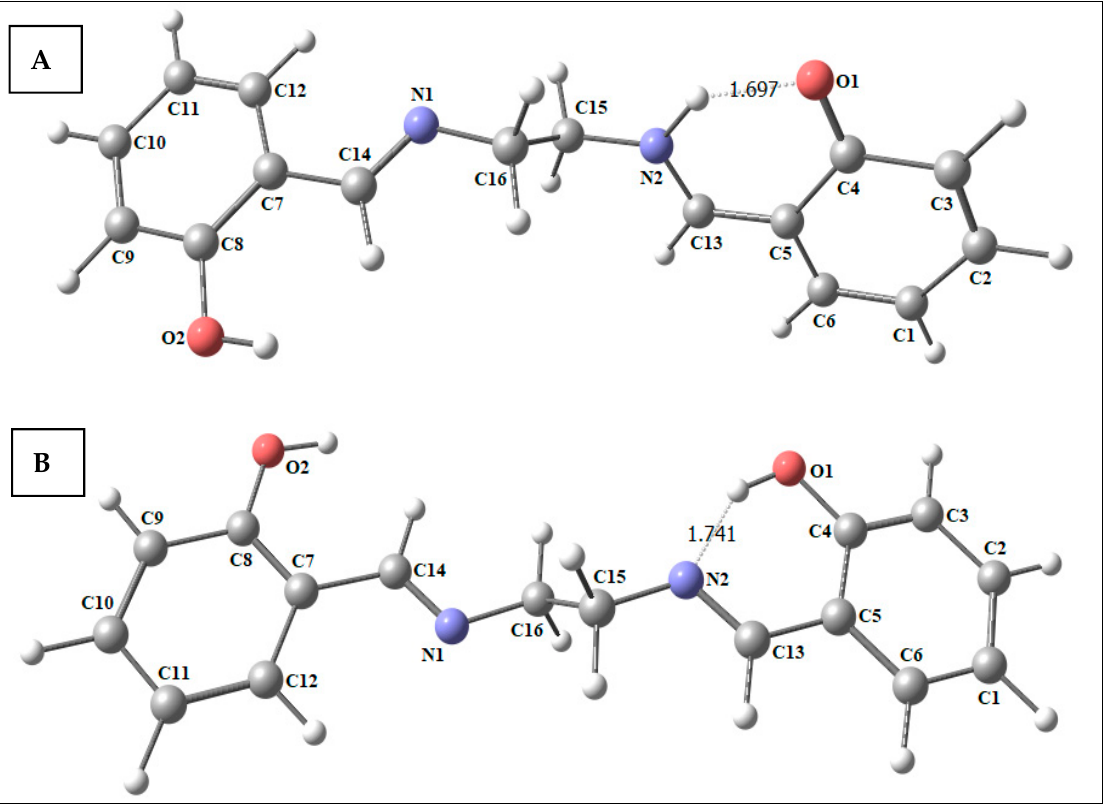
Figure 8. The optimized structure of the keto-enol ( A ) and the enol-enol ( B ) by density function B3LYP/6-311++g(d,p). Figure 9 and Table 6 show the optimized structures and some selected bond distances and angles of the mixed-ligand metal complexes. Table 6. Selected bond distances in Å and angles in ° of the metal metal complexes.